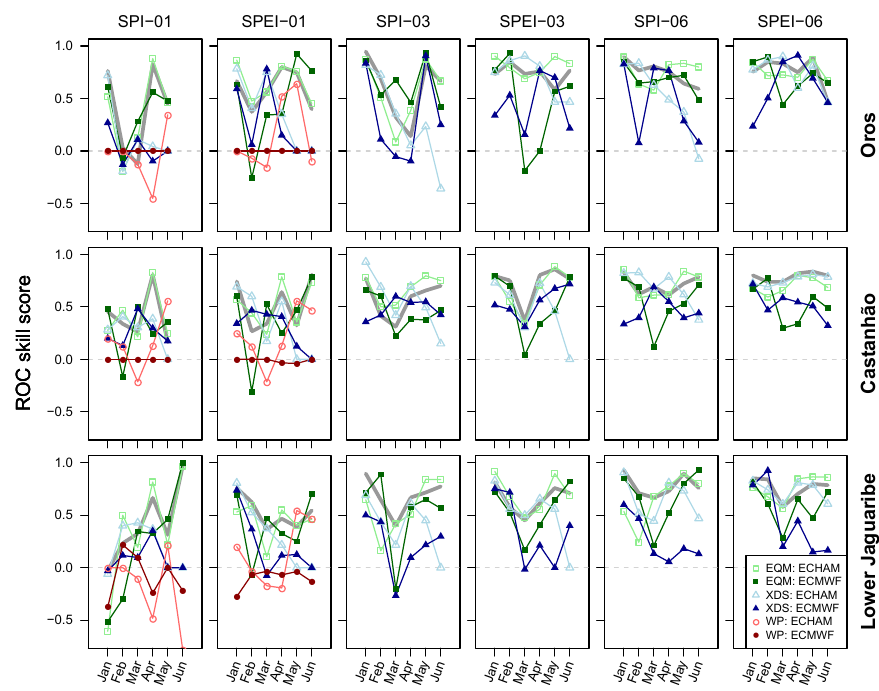
Figure 9. ROCSS of a forecasted meteorological drought event based on an event of an index lower than − 1. The grey line shows the result of the multi-model ensemble